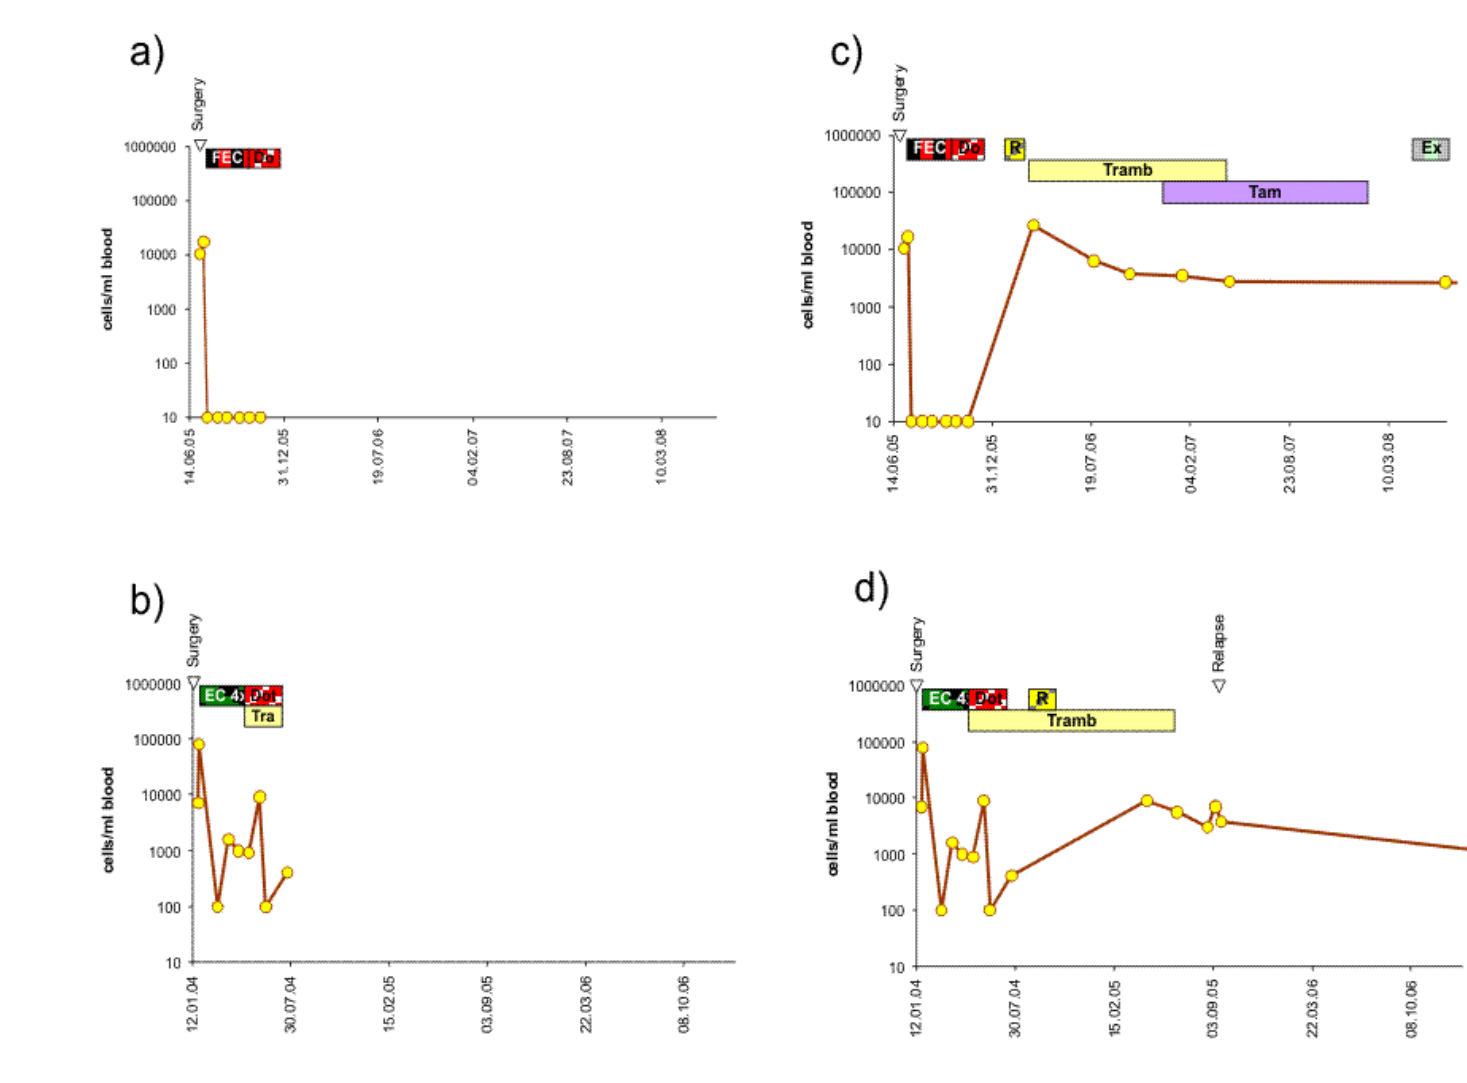
Figure 2. Typical courses of the behavior of vital cells during treatment in (a) and (b) an individual patient with estrogen receptor positive tumor in complete remission and (c) and (d) with relapse. Duration of treatment is shown as bars: FEC: 6 cycles of fluorouracil, epirubicin and cyclophosphamid; FEC Doc: 3 cycles of FEC and 3 cycles of docetaxel; R: local radiation to the breast; Tam: tamoxifen; Tramb: trastuzumab; Ex: